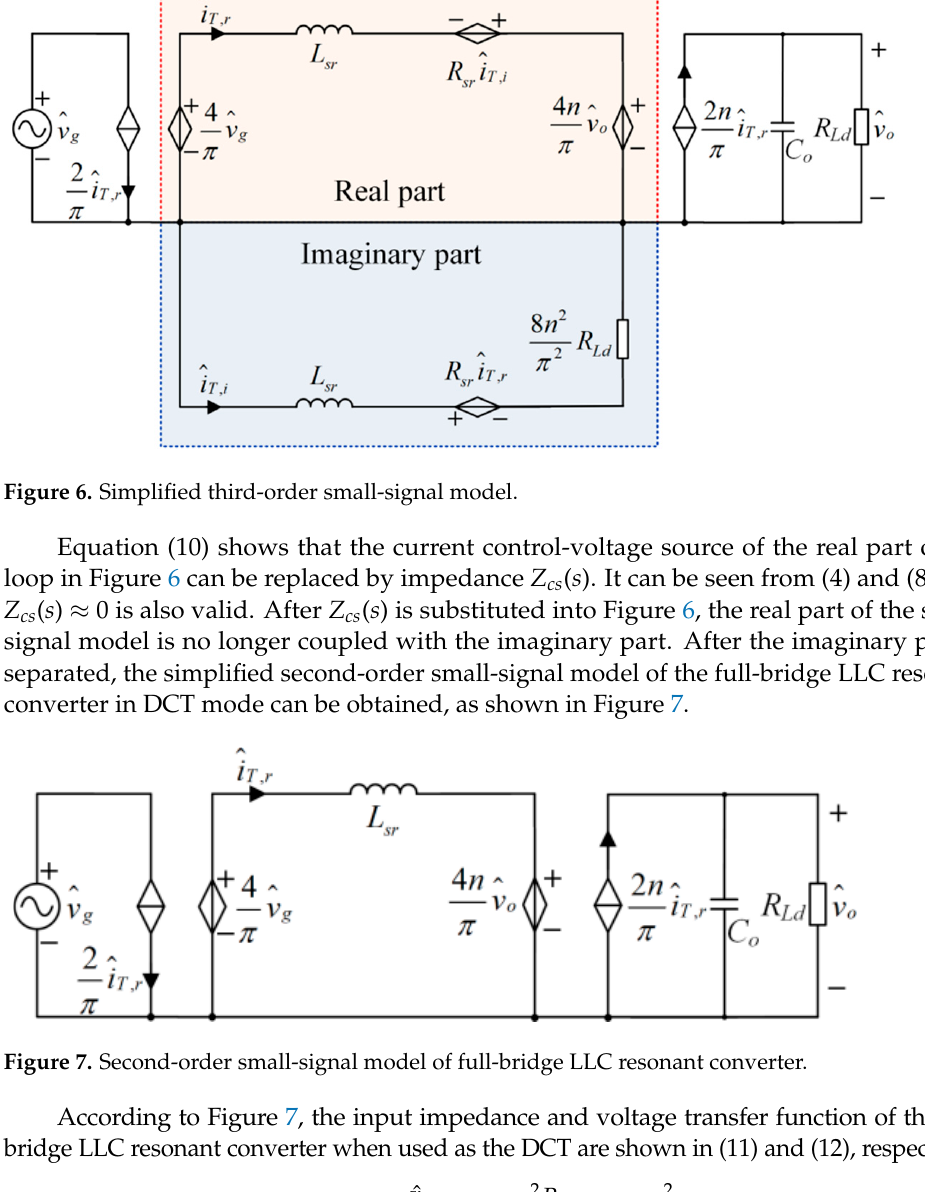
Figure 6. Simplified third-order small-signal model.